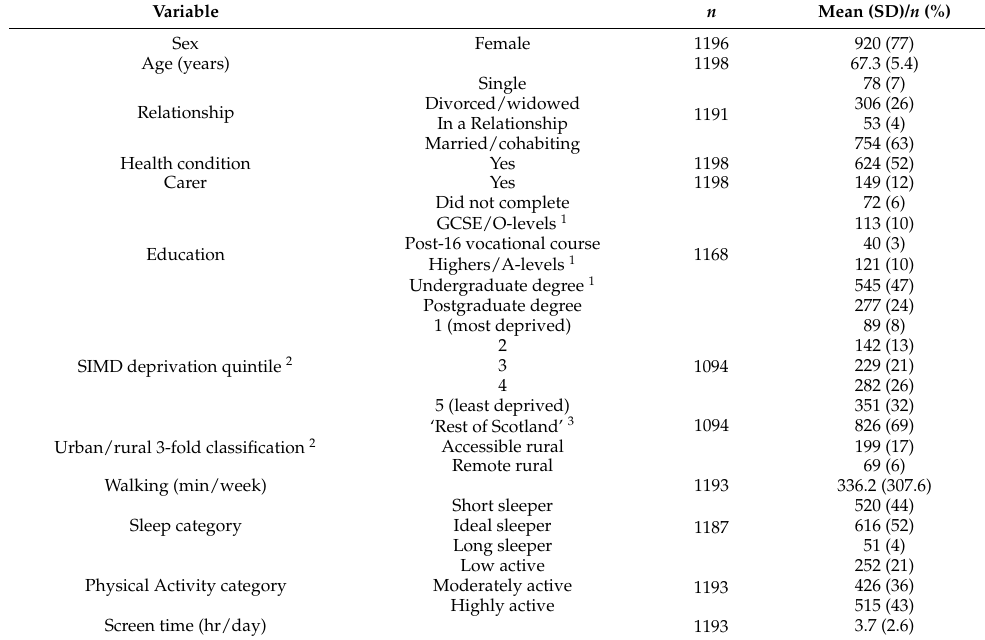
Table 1. Participant descriptive characteristics for participants aged 60+ years (total n =